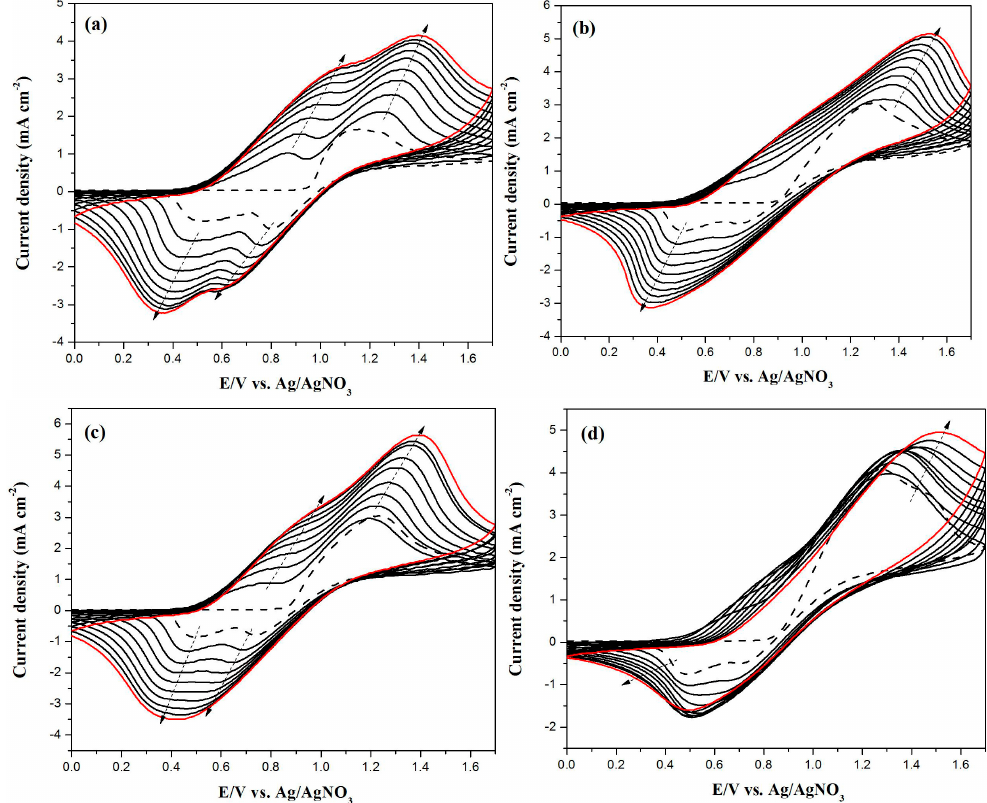
Figure 3. Electrochemical synthesis of: ( a ) PBCz; ( b ) P(BCz- co -EDOT); ( c ) P(BCz- co -ProDOT); and ( d ) P(BCz- co -EDTT) in a PC/ACN (1:1, by volume) solution containing 0.2 M LiClO 4 at 100 mV ∙ s − 1 on ITO working electrode. Arrows, red line